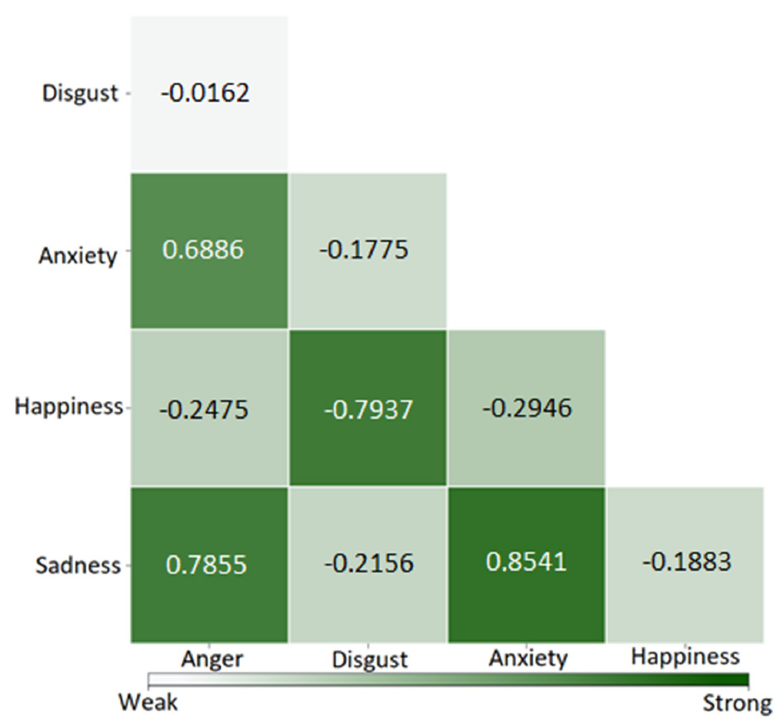
Figure 4. Correlation between measures in the group of sick people.